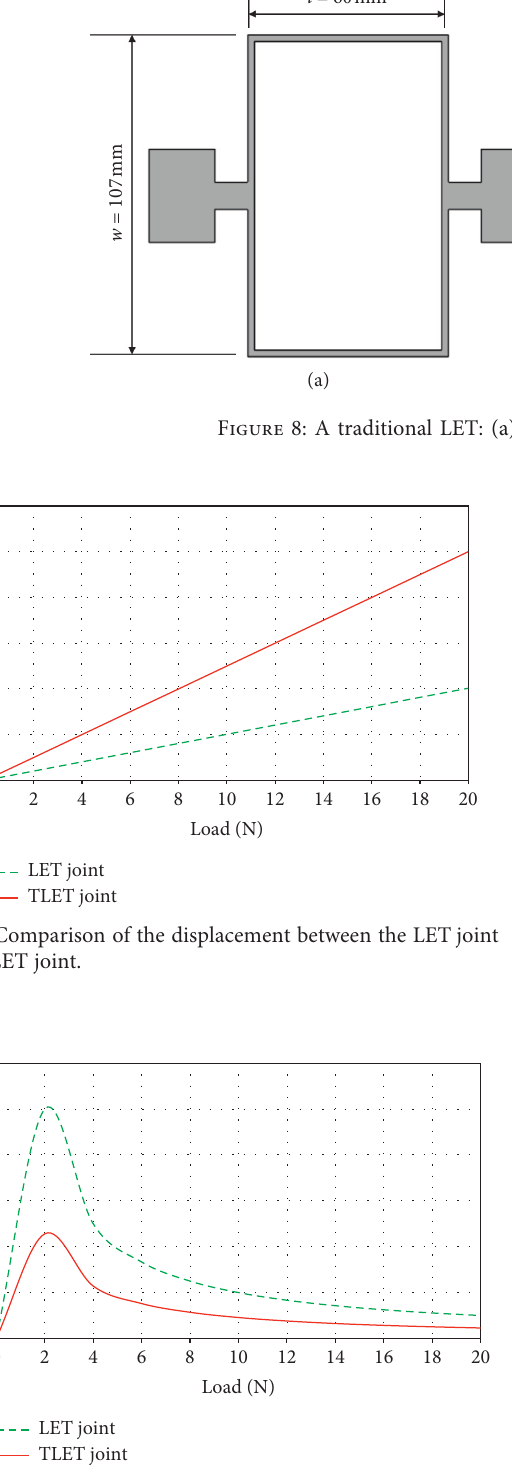
Figure 10: Comparison of the buckling between the LET joint and the TLET joint.